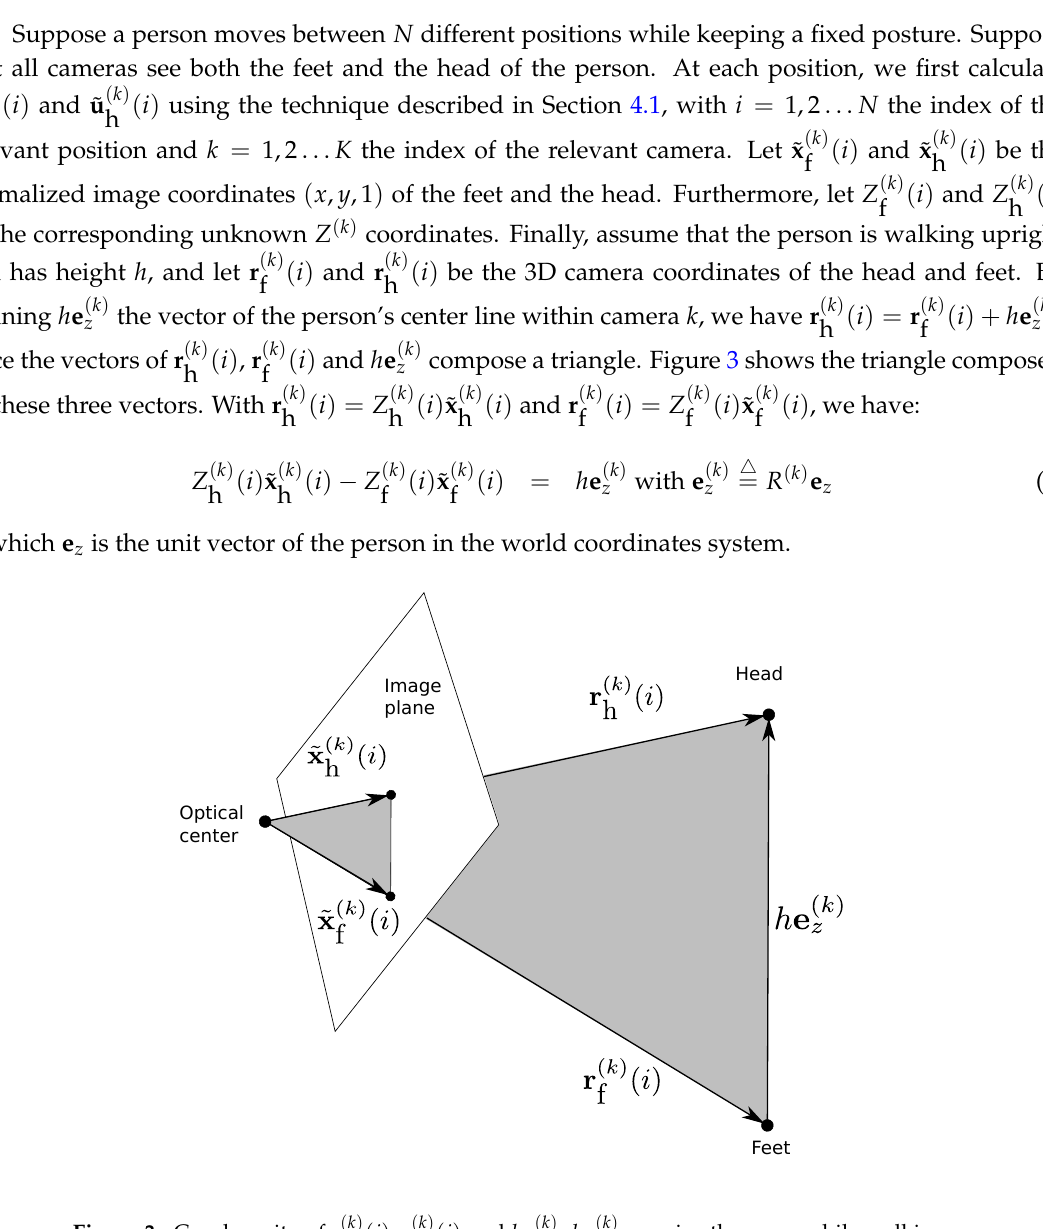
Figure 3. Co-planarity of r